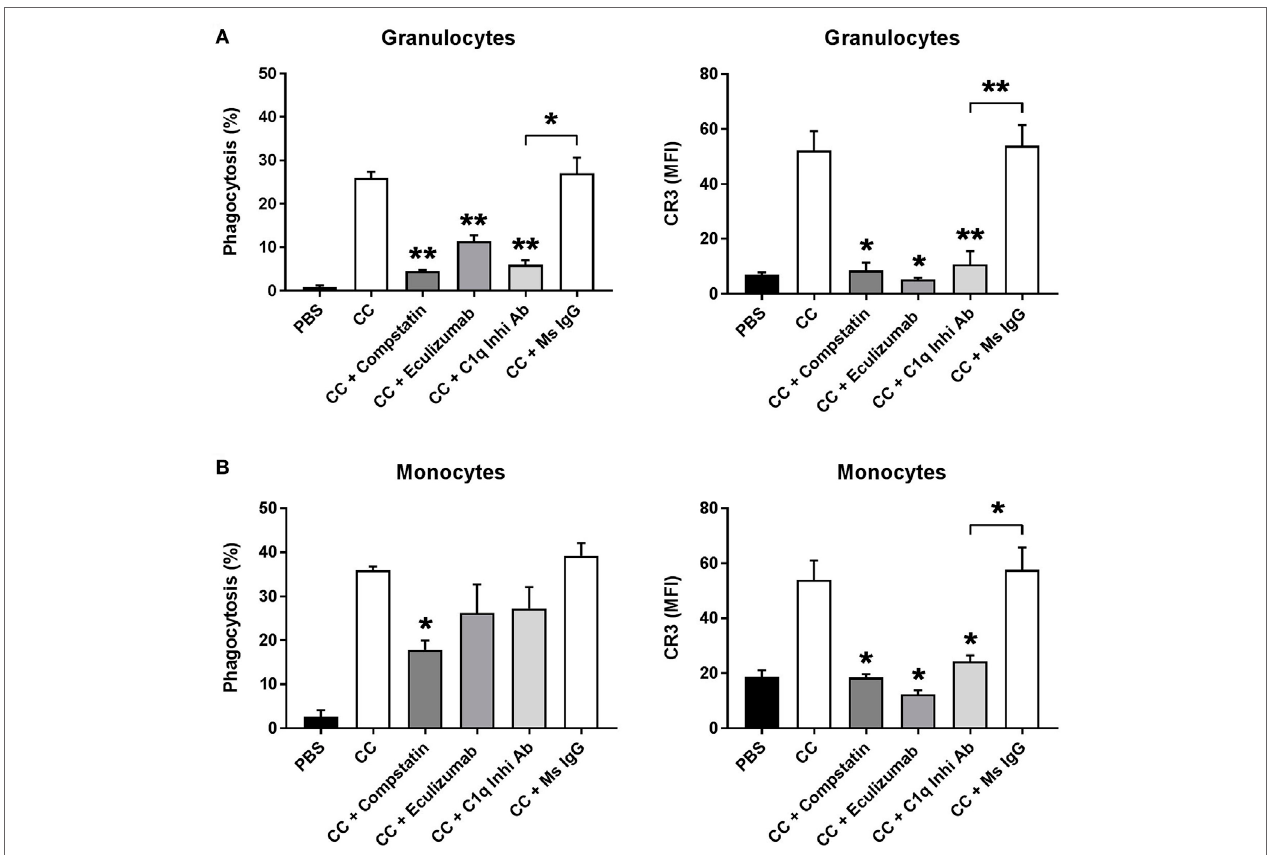
FigUre 5 | Phagocytosis of CCs by granulocytes (a) and monocytes (B) in whole blood is complement dependent and depends on C1q binding. Hirudin whole blood, preincubated 5 min with the C3 inhibitor Compstatin, Cp40, the C5 inhibitor Eculizumab, a C1q inhibitory antibody (C1q Inhib Ab), or a mouse antibody as control (Ms IgG). Whole blood was stimulated with PBS or CC. Phagocytosis was determined as percentage of cells phagocytosing CC determined as a shift in side scatter and by the expression of CR3 measured as MFI. Granulocytes and monocytes were gated based on CD14 expression. Data are given as mean ± SD ( n = 3 healthy donors). * p < 0.05, ** p < 0.01 compared with CC or as otherwise indicated. CC, cholesterol crystals; CR3, complement receptor 3; MFI, median fluorescence intensity; PBS, phosphate-buffered